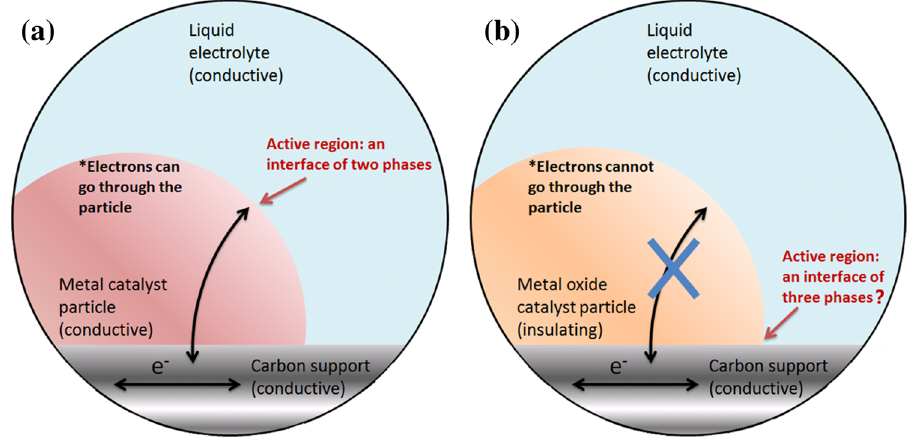
Fig. 1 Schematic display of the difference between the electrochemical interfaces of a a carbon-supported metal and b a metal